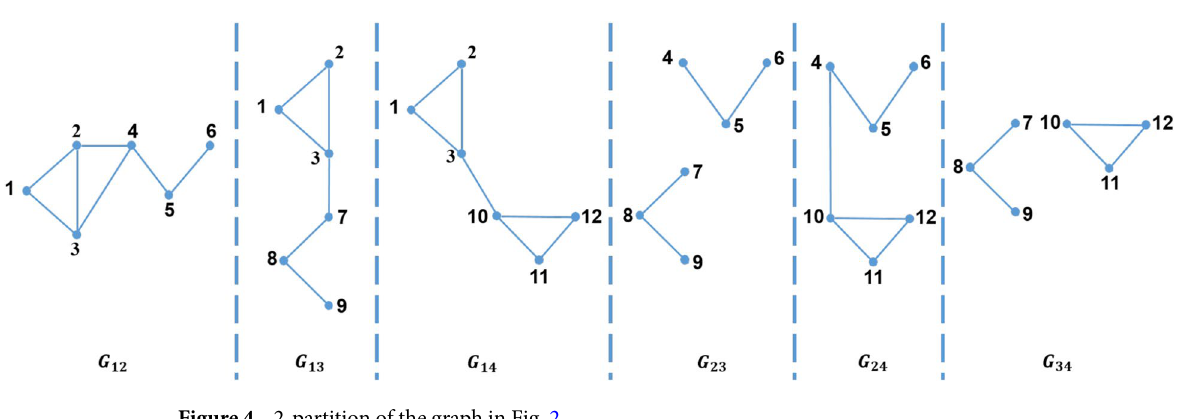
Figure 4. 2-partition of the graph in Fig.